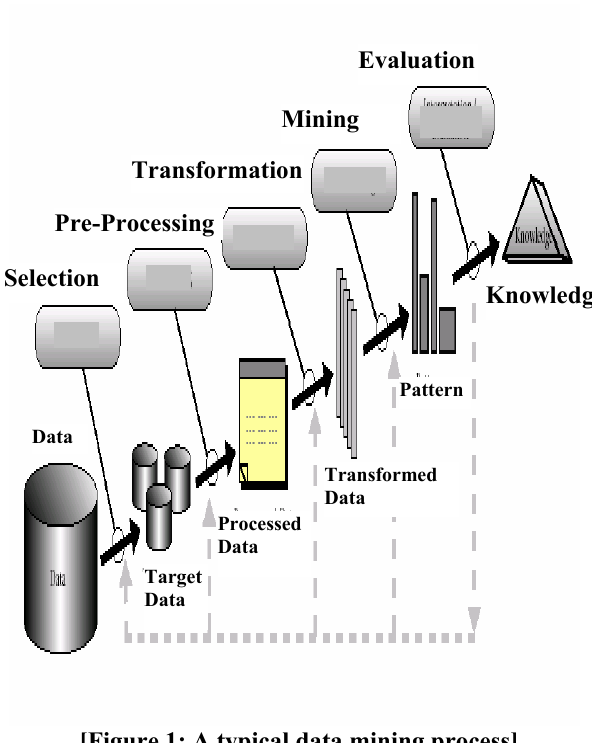
[Figure 1: A typical data mining process] Data Mining is the activity of extracting hidden information (patterns and relationships) from large